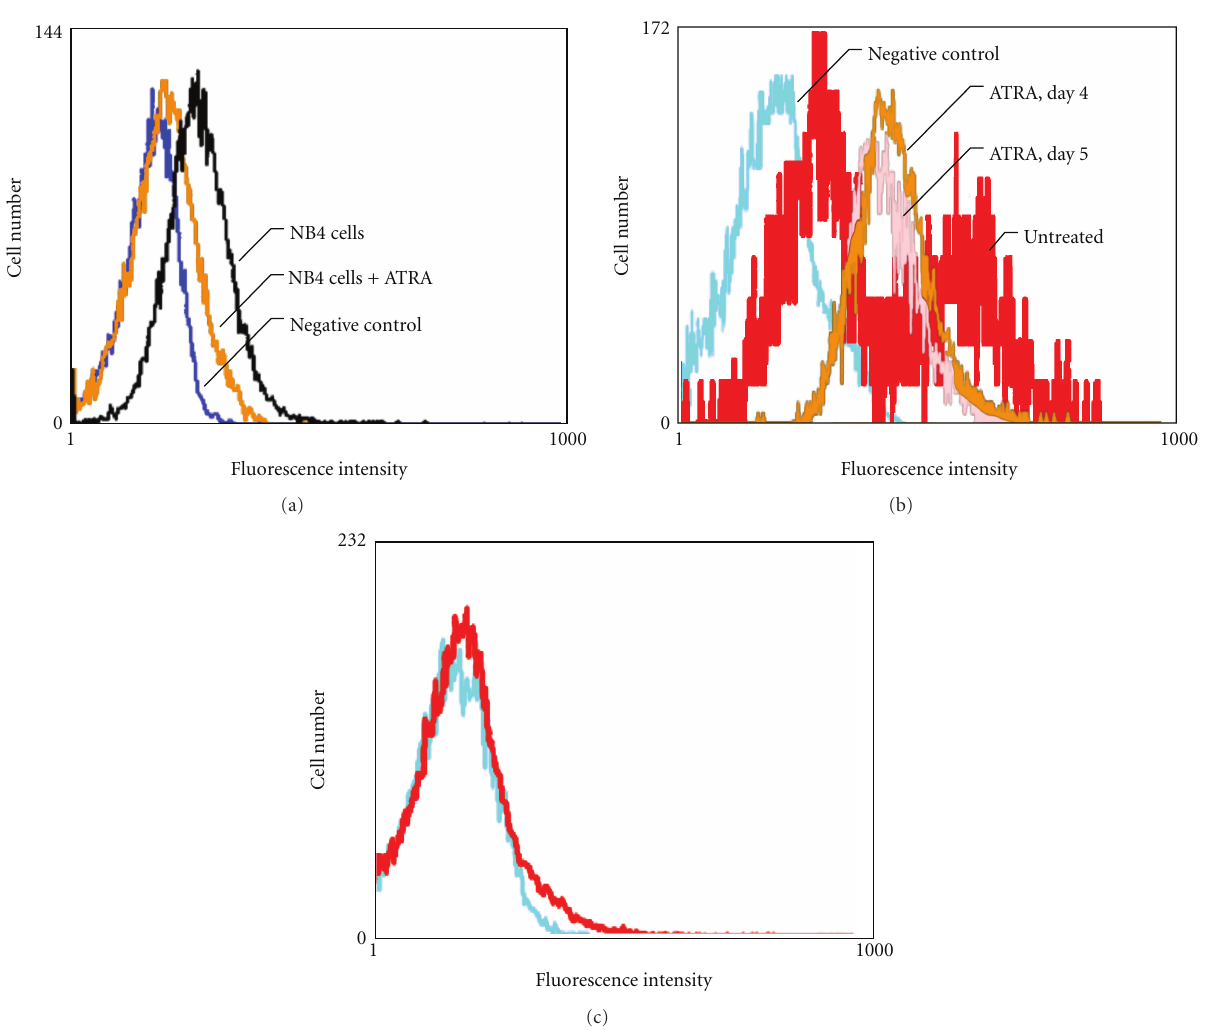
Figure 2: In vitro and in vivo ATRA modulation of plasminogen binding to NB4 cells and APL blast cells. (a) NB4 cells were incubated with 1 μ M all -trans retinoic acid (ATRA) for 48 hours, washed and preincubated with plasminogen (10 μ M) followed by FACS analyses with mAb49 (orange tracing). FACS analyses with mAb49 of untreated NB4 cells preincubated with either plasminogen (black tracing) or bu ff er (blue tracing) detected by antiplasminogen mAb49. (b) Plasminogen bound to blast cells from a patient with APL (CD33+; HLDR Negative) was monitorized in whole blood using mAb49. Analyses were performed at day 0 of ATRA treatment (red tracing) and after ATRA treatment for either 4 days (orange tracing) or 5 days (pink tracing). As a negative control FACS analysis with an isotype control antibody (turquoise tracing). (c) FACS analysis using mAb49 (red tracing) or isotype control (turquoise tracing) of blood from a patient with an M1 leukemia. This research was originally published in